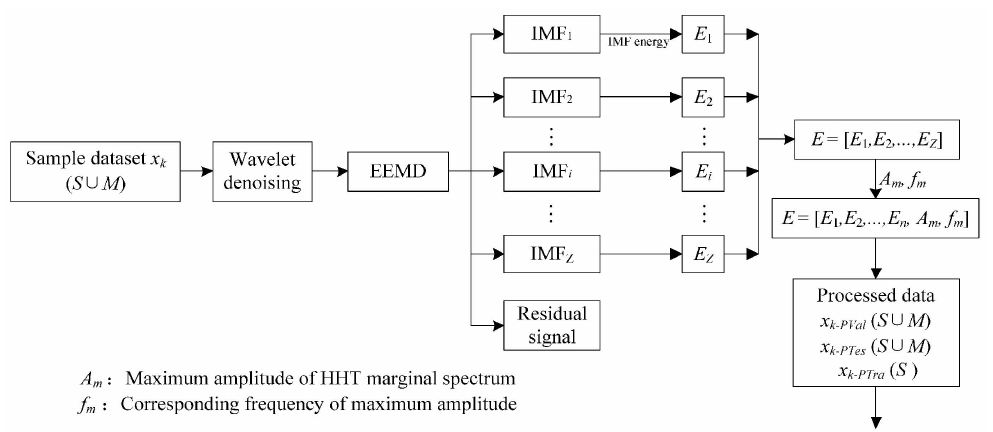
Figure 8. Flowchart of proposed feature extraction